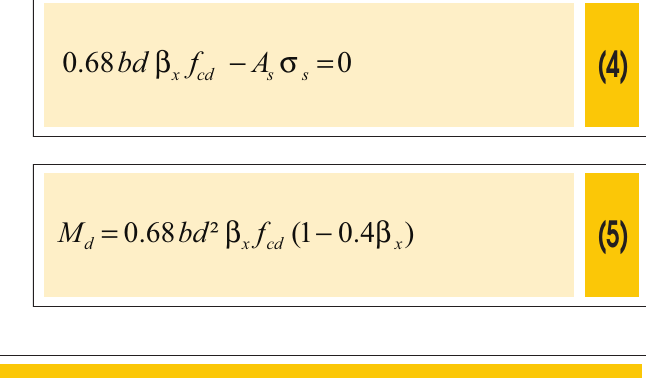
Figure 1 – Pure bending case in rectangular cross-sections considering single and double layer of